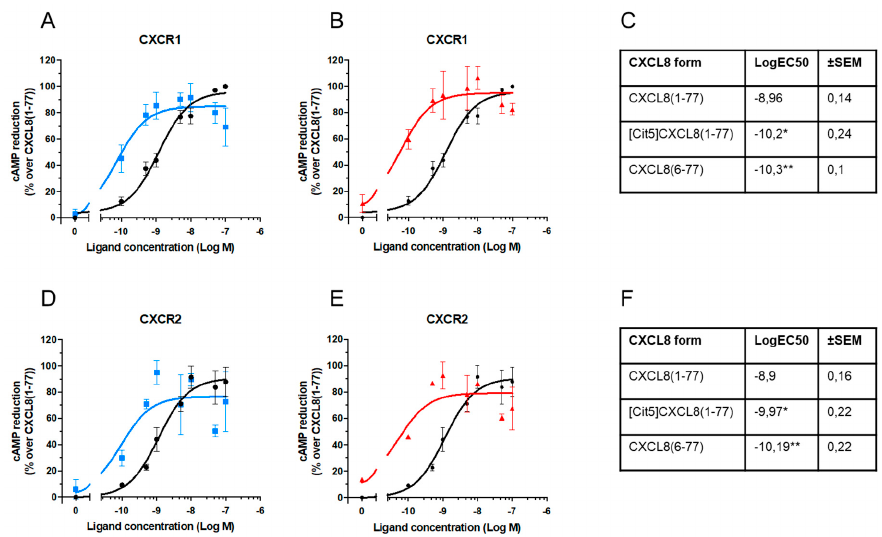
Figure 2. Effects of NH 2 -terminal processing on CXCL8-induced G α i protein-dependent signaling. Dose-response measurements and EC50 calculations were performed based on cAMP Alphascreen technology using HEK-293T cells transfected with CXCR1 ( n = 3) ( A , B , C ) or CXCR2 ( n = 2) ( D , E , F ) after stimulation with the indicated concentrations of CXCL8(1-77) ● , [Cit 5 ]CXCL8(1-77) ■ or CXCL8(6-77) ▲ . In dose-response plots, results are represented as percentages of activity in cAMP reduction over values obtained with authentic CXCL8(1-77) ± SEM. Mean LogEC50 ± SEM were obtained by nonlinear regression curve fitting in the cAMP assays. Results were statically compared by one-way Anova with Tukey multiple comparison. * p < 0.05, ** p < 0.01.